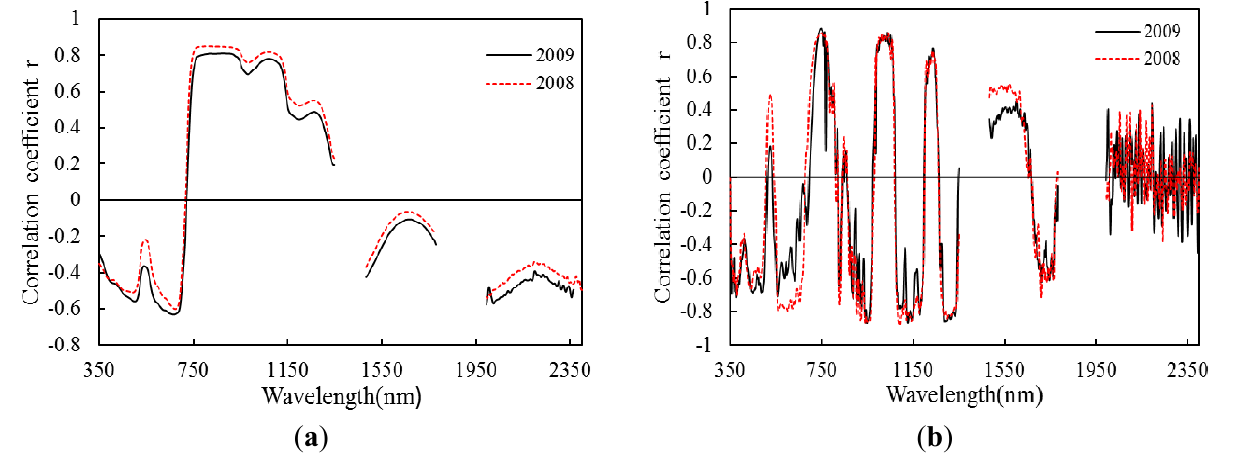
Figure 2. Correlation analysis of reflectance spectra ( a ) and first derivative spectra ( b ) against LAI for each wavelength.